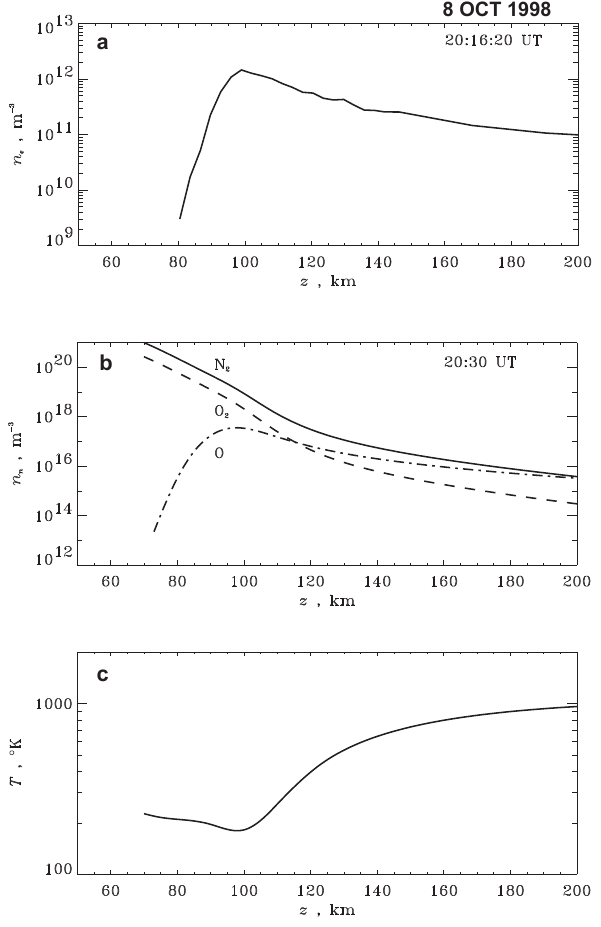
Fig. 2. Ionospheric conditions observed during the period of the FAST observations: (a) electron density n e measured by the EIS- CAT UHF incoherent scatter radar; (b) molecular composition n n and (c) temperature in the midnight sector as deduced from the iono- spheric model MSIS90.